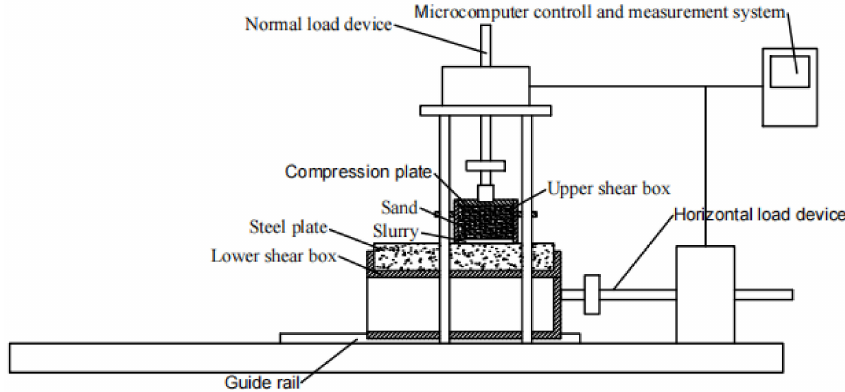
Figure 2. Schematic diagram of the direct shear apparatus.